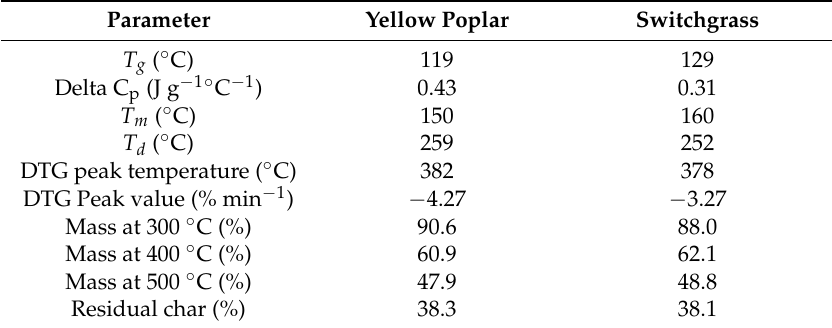
Table 3. Summary of key thermal properties of switchgrass and yellow poplar lignin samples. Parameter Yellow